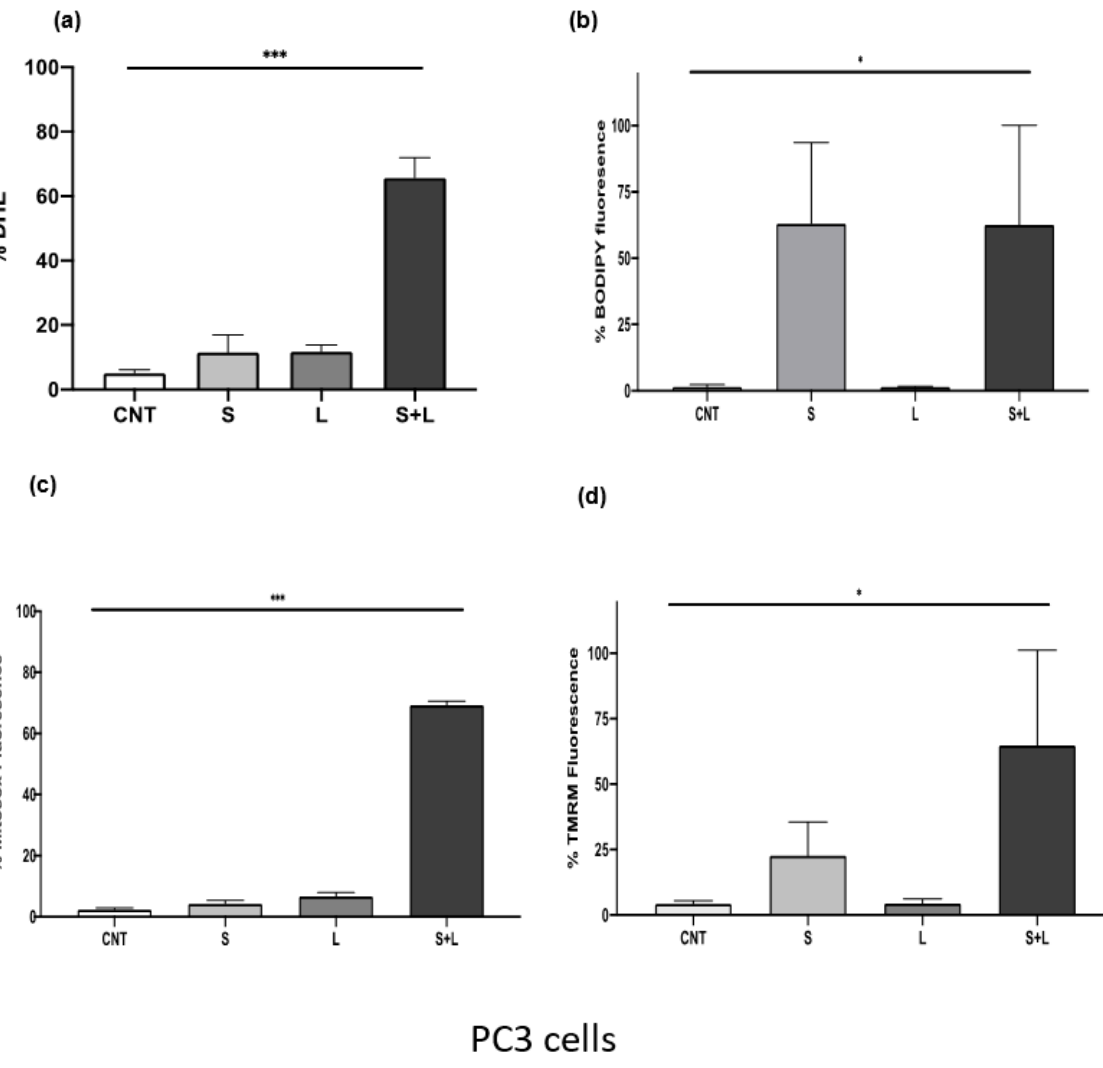
Figure 7. Siramesine and lapatinib increase reactive oxygen species, lipid peroxidation while decreasing mitochondrial membrane potential and generating mitochondrial super oxide. PC3 cells were treated with 10 μ M siramesine and 0.5 μ M lapatinib for 24 h. ( a ) To detect reactive oxygen